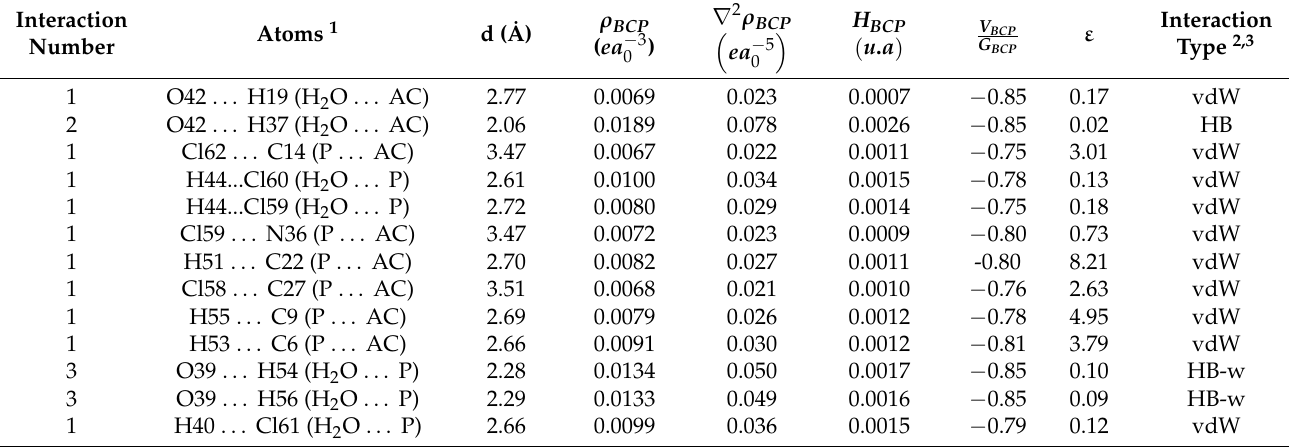
Table 1. Interatomic distances (d), electron density ( ρ BCP ), Laplacian of electron density ( ∇ 2 ρ BCP ), total energy density ( H BCP ), potential-kinetic energy density ratio ( V BCP / G BCP ), and ellipticity of the electron density ( ε ) at the bond critical points (BCPs) for the system NH 2 / β -HCH/(H 2 O) 2 .